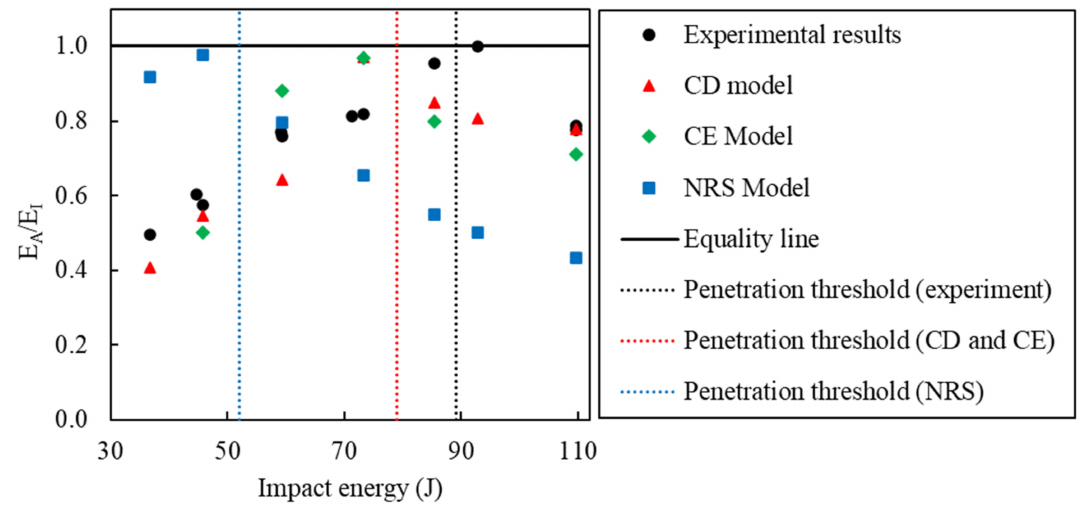
Figure 11. Prediction of perforation threshold from the CD and NRS models in comparison to the experimental